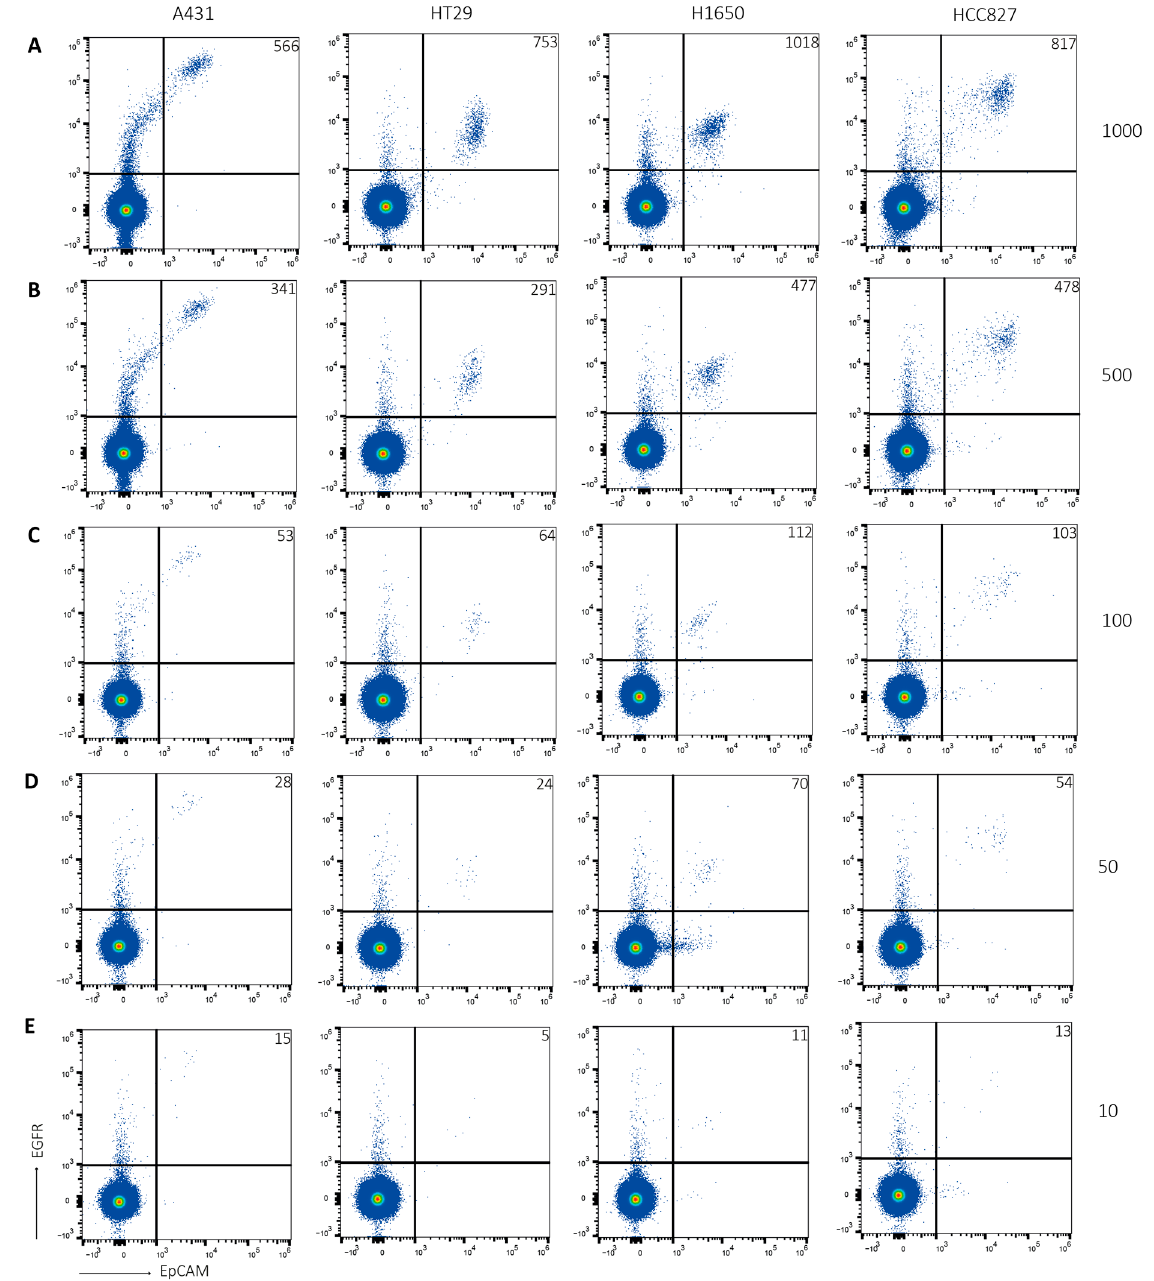
Figure 2. Low numbers of multiple tumor cell lines can be detected in blood. Healthy donor blood was spiked with ( A ) 1000, ( B ) 500, ( C ) 100, ( D ) 50 or ( E ) 10 A431 cells (first column), HT29 cells (second column), H1650 cells (third column) or HCC827 cells (fourth column). After PBMC isolation, samples were stained for EpCAM and EGFR, and analyzed using the Attune NxT. Tumor cells were detected by EpCAM+EGFR staining. Number of detected tumor cells is indicated in upper right corner. Representative figure of N = 3.